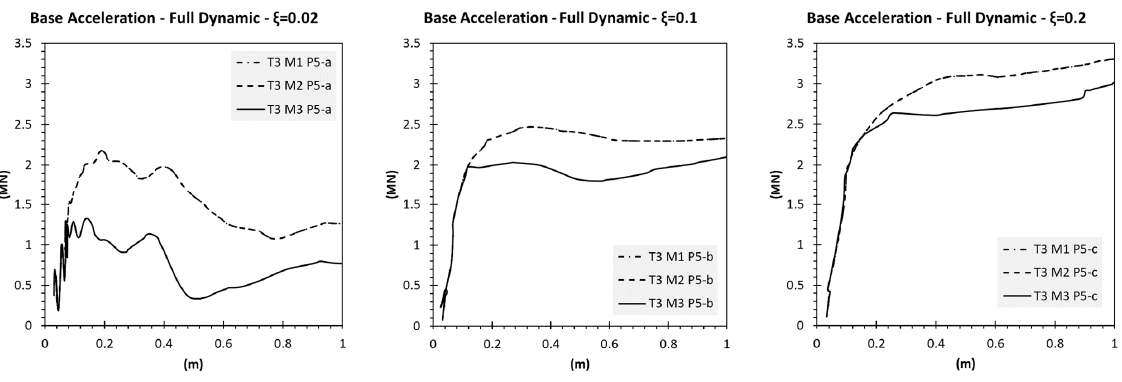
Figure 8. Role of damping in the pseudo-static pushover curves, from left to right the damping ratio increases from 0.02, 0.1 and 0.2.